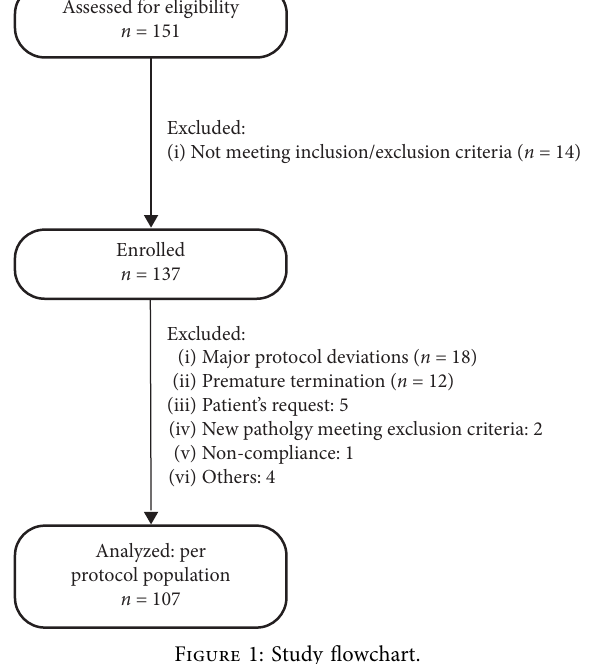
Table 1: Baseline